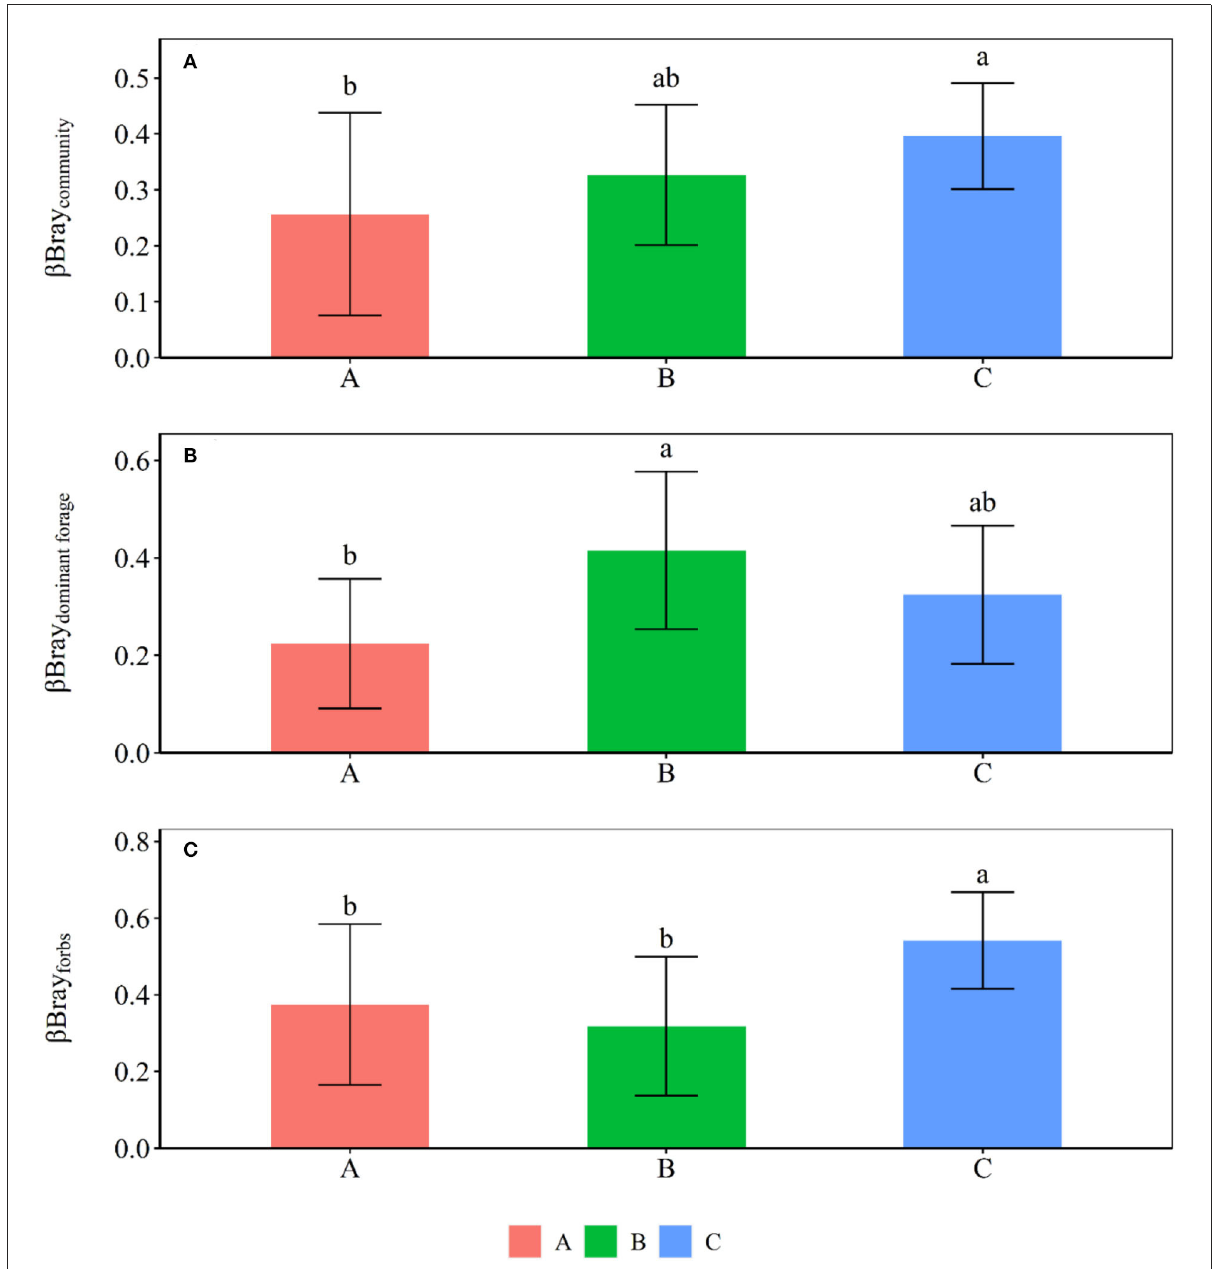
FIGURE4 Comparisons of β Bray (mean ± SD) between the fencing and grazing conditions at the three sites for (A) plant community, (B) high-quality forage, and (C) forbs, respectively. Different letters indicate significant difference at p < 0.05 level.